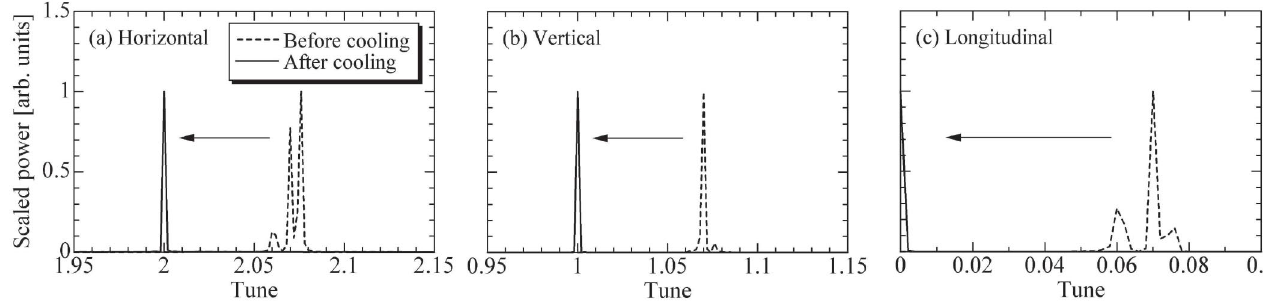
FIG. 12. Fourier spectra of single-particle oscillations before and after laser cooling. The orbit data obtained in the MD simulation of Fig. 10 have been Fourier transformed.